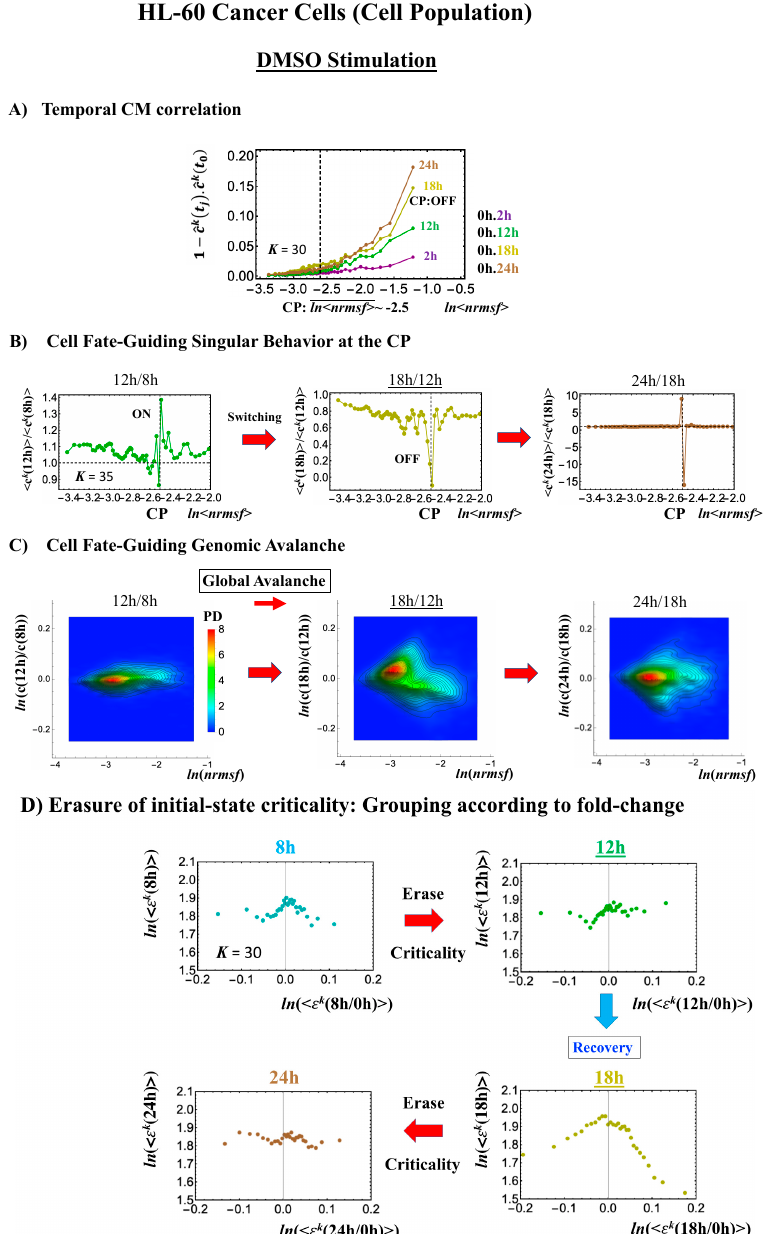
Figure 6. DMSO-stimulated HL-60 cell population. ( A ) The divergent behavior of the temporal CM correlation with the initial whole-genome expression ( t = 0) occurs at 18 h ( K = 30: n = 420